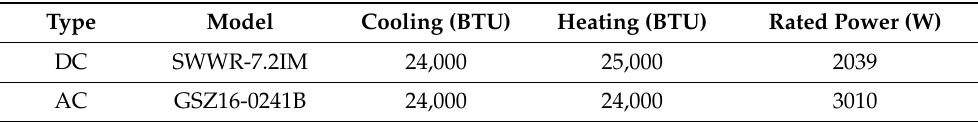
Figure A1. Average load profiles of water heater, HVAC, Lighting, and IE. Table A1. AC and DC HVAC